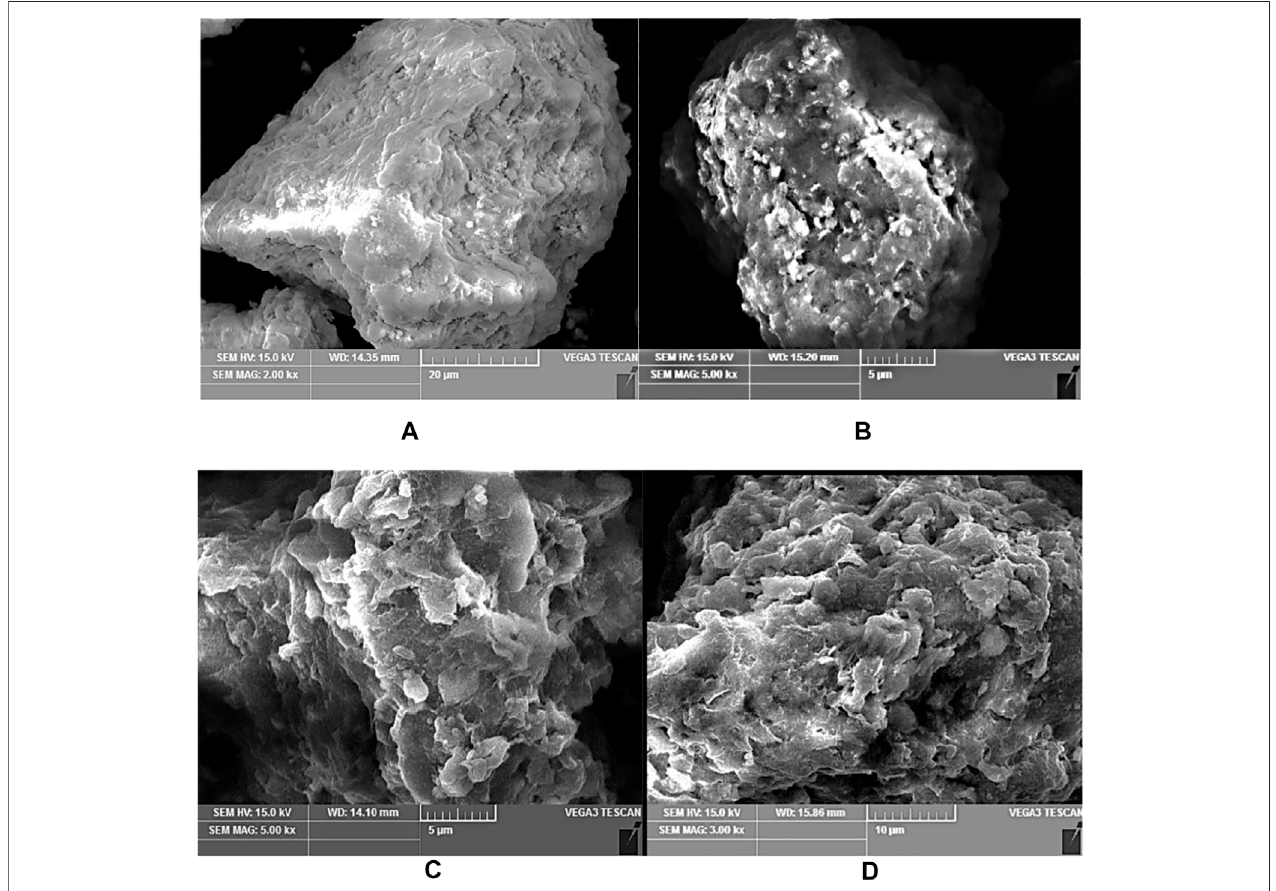
FIGURE 2 | (A) SEM image of Original soil, (B) Calcination at 300 ° C, (C) Calcination at 400 ° C, (D) Calcination at 500 ° C.